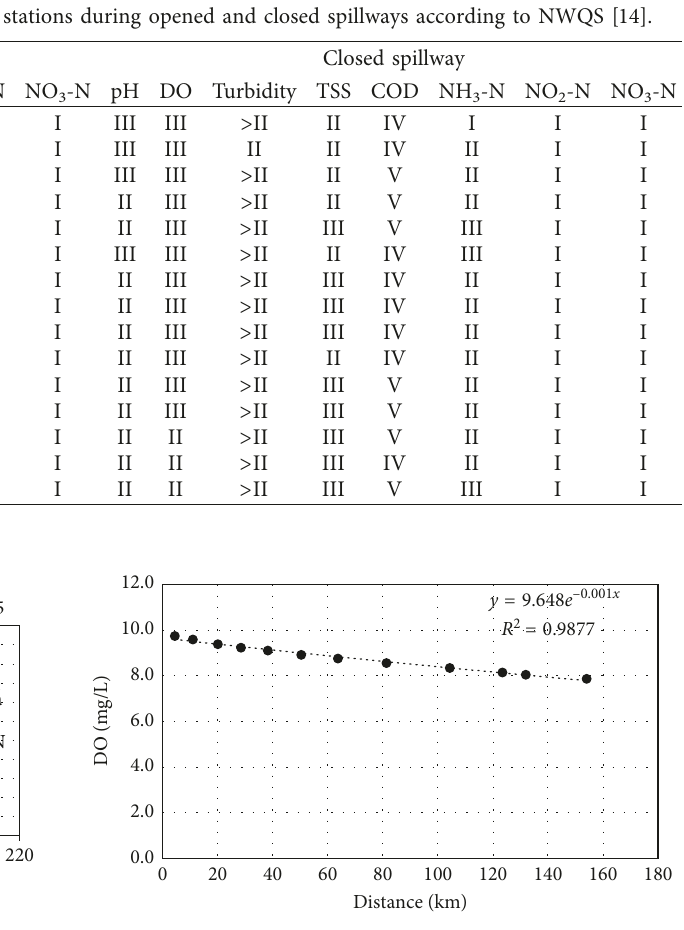
Figure 5: Exponential decay model fit of DO up to a distance of 154km away from the Bakun Dam during opened